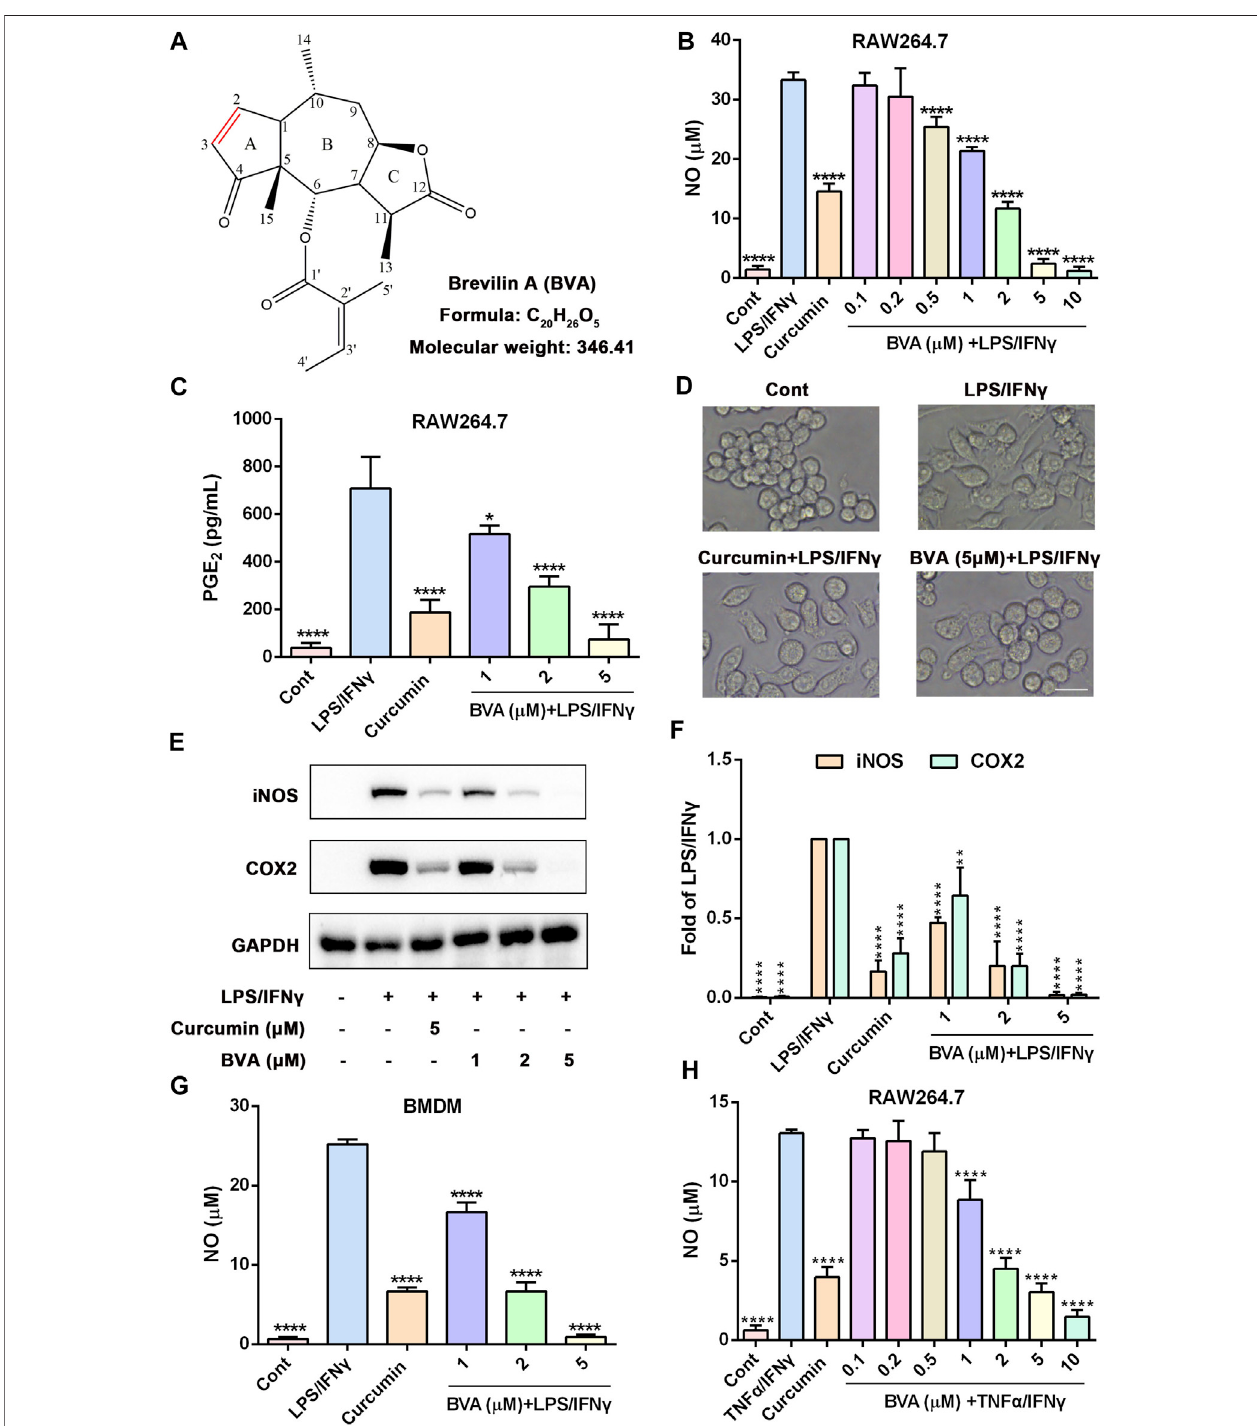
FIGURE1| Brevilin Ainhibits thein fl ammatory responseinvitro. (A) The chemical structure ofbrevilin A(BVA). RAW264.7 cellsweretreatedwithBVA orcurcumin (5 μ M) for 1 h, and then stimulated with LPS/IFN γ (0.5 and 10 ng/ml) for 24 h. The production of NO (B) and PGE2 (C) were detected by Griess reagent or ELISA kit, respectively. (D) The representativemorphological changes ofRAW264.7 cells areshown. Scale bar =25 μ m. (E) The whole-cell lysates were immunoblotted with anti- iNOS and anti-COX2 antibodies, respectively. GAPDH was shown as the loading control. (F) The quantitative results of the ratio of iNOS or COX2 normalized to GAPDHareshown.BMDMs (G) orRAW264.7 (H) weretreatedwithBVAorcurcuminfor1 h,andfollowingincubatedwithLPS/IFN γ orTNF α /IFN γ (10and10 ng/ml)for additional 24 h. The NO release was measured by Griess reagent. * p < 0.05, ** p < 0.01, *** p < 0.001, **** p < 0.0001, vs. LPS/IFN γ or TNF α /IFN γ .